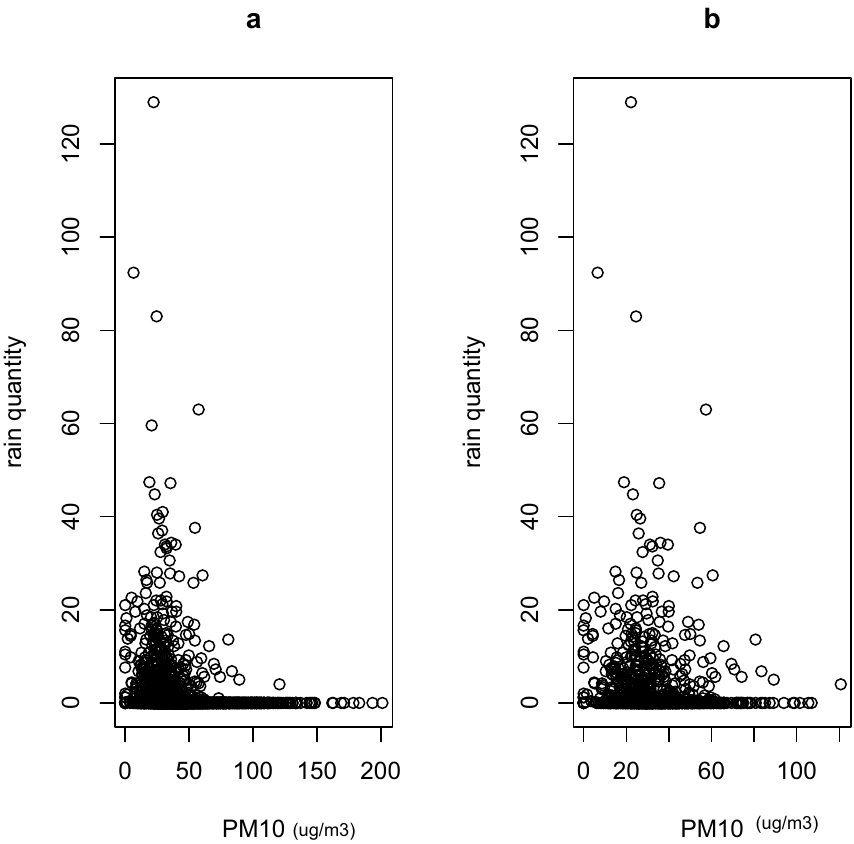
Figure 1. Rain quantity as a function of PM10. ( a ) For full year and ( b ) for only rainy season. Rain quantity is in mm.